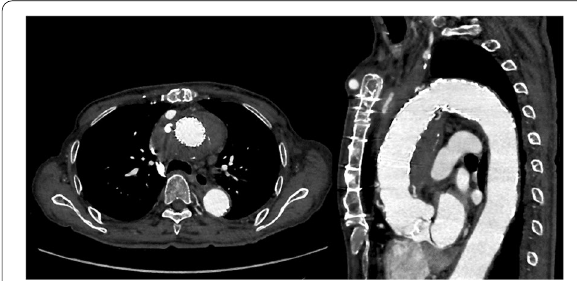
Fig. 3 Postoperative computed tomography findings. Postoperative computed tomography shows no